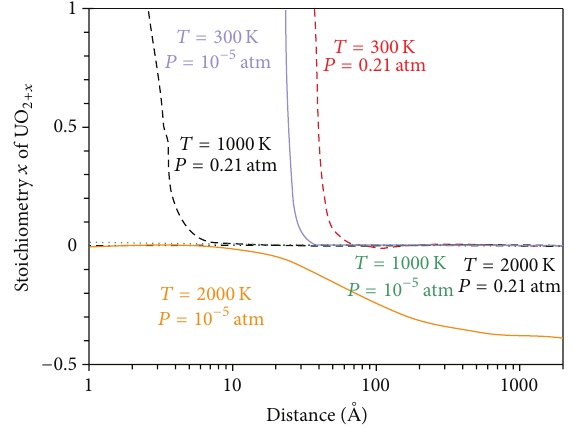
Figure 5: Modeling results of temperature (300, 1000, and 2000 K) and oxygen partial pressure (0.21 and 10 −5 atm) dependence of the near (110) surface stoichiometry in UO 2